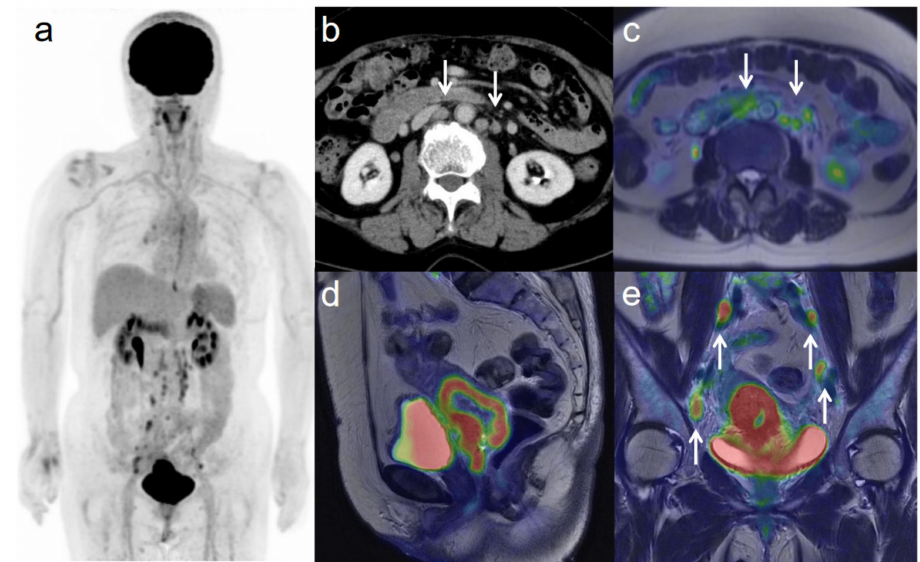
Figure 4. A 75-year-old woman with IIIC2 cervical cancer and paraaortic lymph node metastasis. ( a ) 18 F-FDG PET image FDG uptake by tumor in the cervical cervix (arrow) and pelvic and paraaortic lymph nodes. ( b ) CT shows paraaortic lymph nodes of short-axis diameter >1 cm (arrows). ( c ) Axial T2-weighted PET/MR image shows FDG uptake by the paraaortic lymph nodes (arrows). This finding is strongly suggestive of paraaortic lymph node metastasis. After radiotherapy, the size and SUV of the lymph nodes decreased, further suggesting malignancy. ( d ) Sagittal T2-weighted PET/MR image shows FDG uptake by the cervical tumor. ( e ) Coronal T2-weighted PET/MR image shows FDG uptake by the cervical tumor and pelvic lymph nodes (arrows).